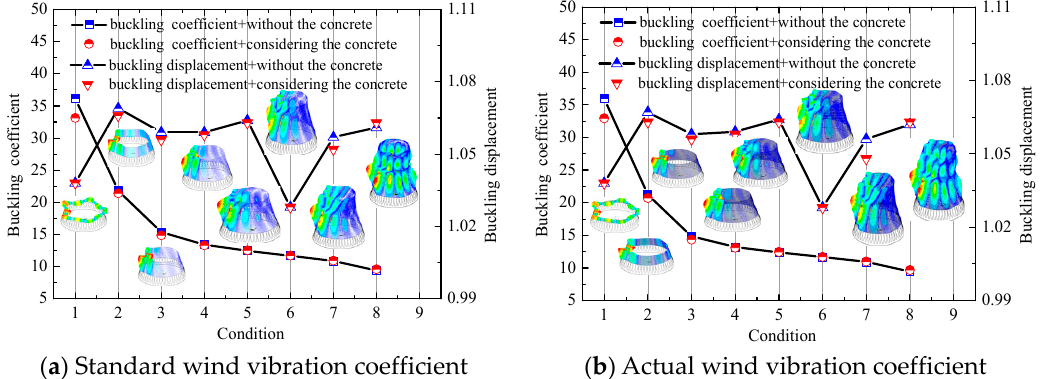
Figure 13. Changes of buckling coefficient and buckling displacement under eight working conditions.